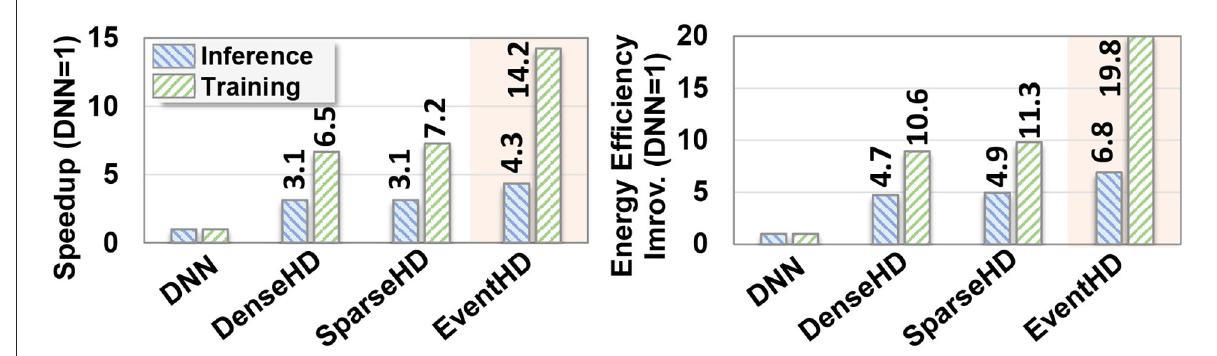
FIGURE8 Efficiency analysis: Comparison of EventHD performance speedup and energy efficiency with state-of-the-art algorithms on the FPGA platform. The results are reported for both training and inference phases and is normalized relative to DNN performance and energy efficiency. During training (inference), EventHD achieves, on average, 10.6 × (14.2 × ) faster and 16.3 × (19.8 × ) more energy-efficient computation as compared to FPGA-based DNN implementation, respectively.